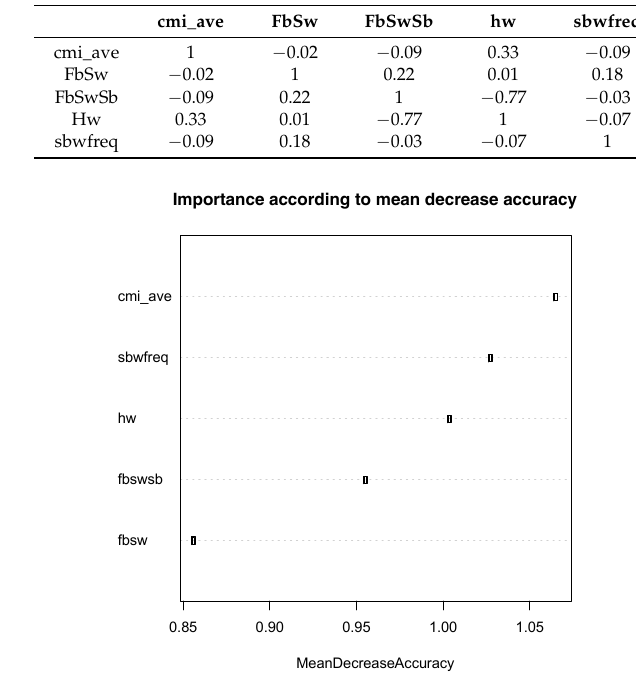
Figure 6. Classification tree of the presence (1) or absence (0) of the interaction between fire and spruce budworm defoliation as a function of just the two most important explanatory variables (Figure 5) from the data used to grow the tree shown in Figure 3. These two variables are the frequency of